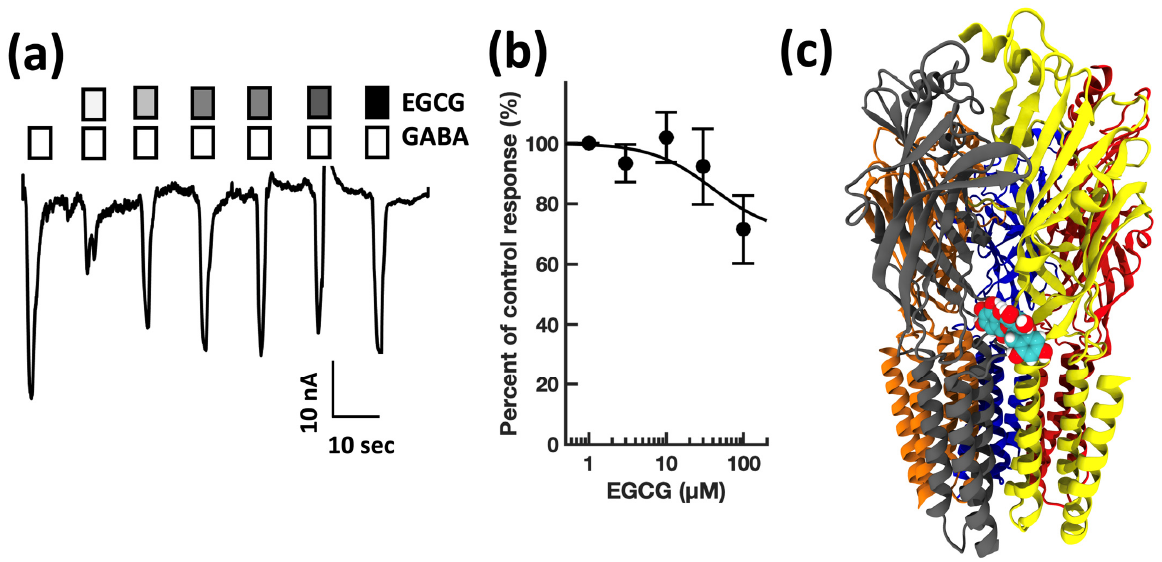
Figure 8. EGCG modestly inhibits GABA A receptor activation in a concentration-dependent manner, and preferentially docks at the α + β Interface in a pocket defined by a TM23 linker, a cys-loop,